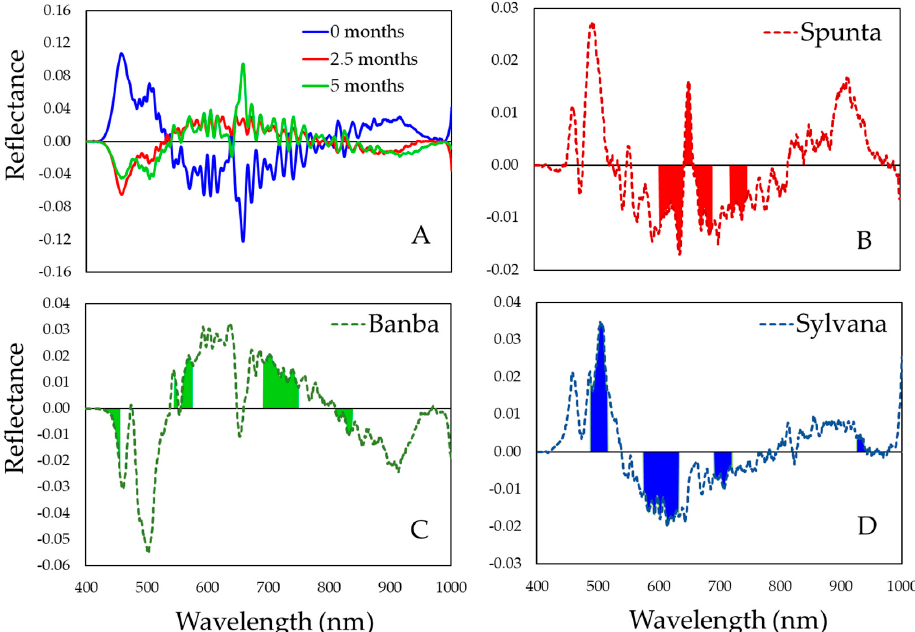
Figure 2. Spectra reflectance data upon pre-processing (normalization, Savitzky–Golay first derivative and mean centering) that were externally captured on the skin of the tuber during storage for 0, 2.5, or 5 months at 5 °C ( A ) from 3 commercial potato cultivars (Spunta, Banba, and Sylvana), along with the most important regions within each cultivar for the freshness assessment ( B – D ).